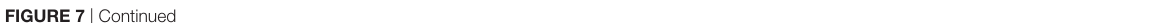
FigUre 7 | Continued Accumulated macrophages in gut tissues are involved in resistance to high-fat diet-induced obesity. (a) Dynamics of macrophages from the ileum tissues of HFV/N (Lu-actin) mice with Lactobacillus NK318.1 gavage. The macrophages isolated from the gut tissues of HFV/N (Lu-actin) mice with Lactobacillus NK318.1 gavage were injected into WT mice, and then macrophages in the adipose tissues of WT mice were analyzed at the indicated time. (B) Flow cytometry of CD45.1( + ) F4/80( + ) macrophages in the adipose tissues and spleen at the different times after injecting gut macrophages of CD45.1( + ) mice with Lactobacillus NK318.1 gavage . AT, adipose tissues; SP, spleen. (c) Immunostaining of macrophages in the adipose tissues after injecting gut lamina propria macrophages of CD45.1( + ) mice with (CD45.1/L.NK.1) or without (CD45.1/NC) Lactobacillus NK318.1 gavage. (D–g) Body weights (D) , fat pad (e) , glucose (F) , and insulin tolerance (g) in mice injecting freshly isolated macrophages from the ileum tissues of mice with (Mac/L.NK.1) or without (Mac/NC) Lactobacillus NK318.1 gavage. * p <